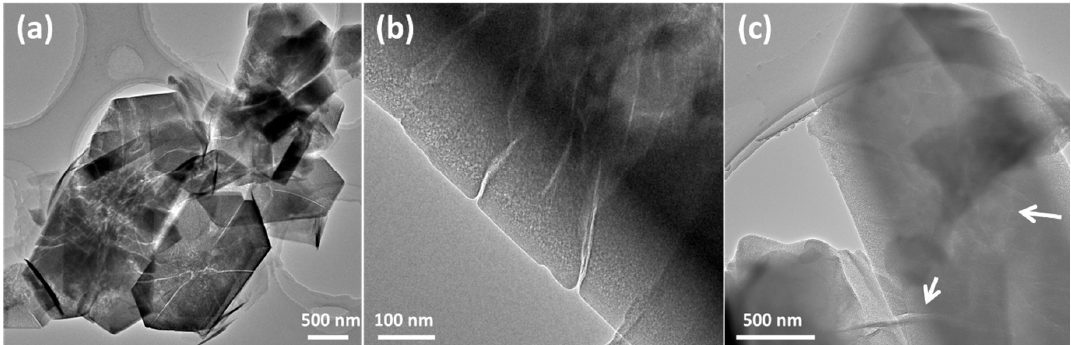
Figure 1. TEM images of mesostructured samples. ( a ) hierarchical zeolite (HZ); ( b ) enlargement of edge area of HZ; ( c ) hierarchical mesoporous zeolite (HMZ).